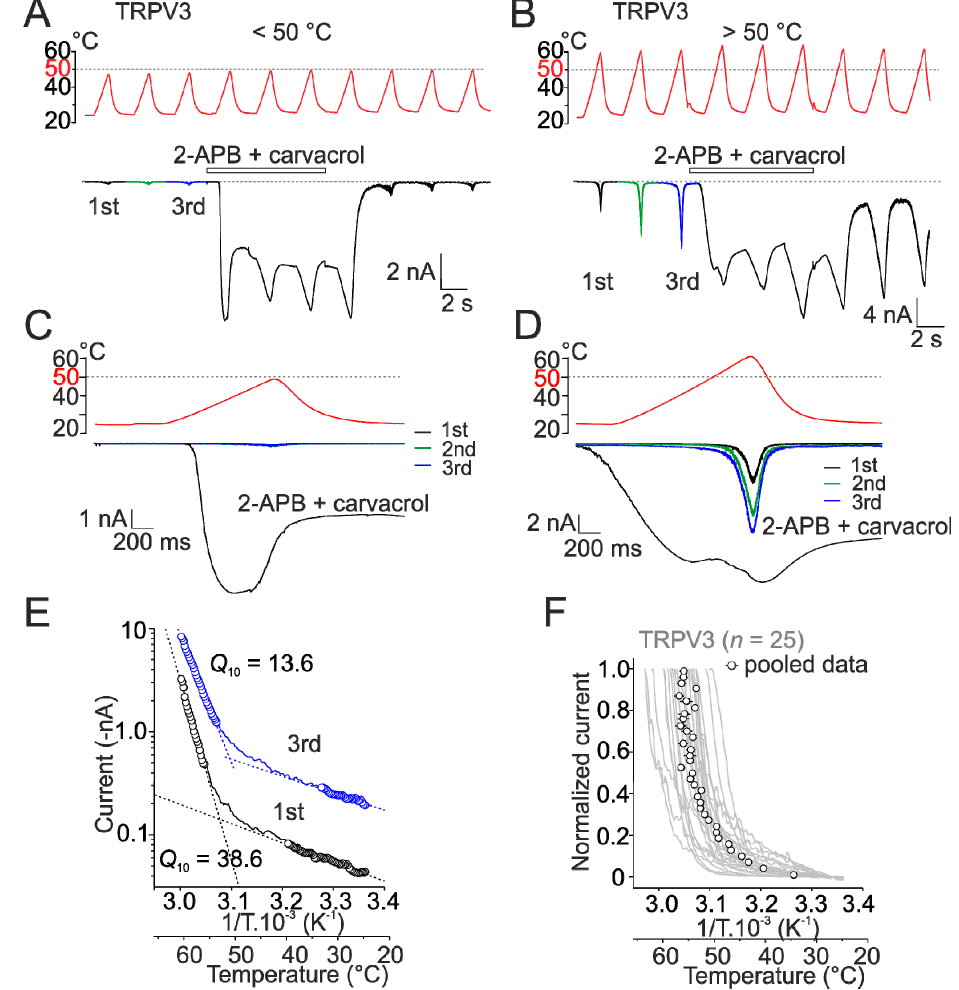
Figure 2. Activation of TRPV3 at temperatures above 50 °C. ( A , B ) Representative whole-cell currents evoked by heat stimuli below ( A ) or above ( B ) 50 °C, applied at − 70 mV in wild-type TRPV3, in the absence or presence of mixed agonists (100 µM 2-APB + 100 µM carvacrol). ( C , D ) Expanded traces of the first to fourth heat responses (the fourth recorded in the presence of agonists) are shown below the recordings from A and B. ( E ) Comparison of the 1st and 3rd heat responses recorded in the absence of agonists from the cell shown in B. Arrhenius plot in which the current ( y -axis, log scale) was plotted against the reciprocal of the absolute temperature ( x -axis). The temperature coefficient, Q10, was estimated by linear regression (dashed lines) from the slope of the Arrhenius plot in the temperature ranges indicated by open circles. ( F ) Heat-induced currents measured from 25 cells expressing wild-type TRPV3, normalized to maximum responses. Pooled values of normalized heat-induced currents through wild-type TRPV3 (open circles with bi-directional grey bars indicating S.E.M.; n = 25). Currents from individual cells are overlaid for comparison (grey lines). In some cases, the error bars are smaller than the symbol.